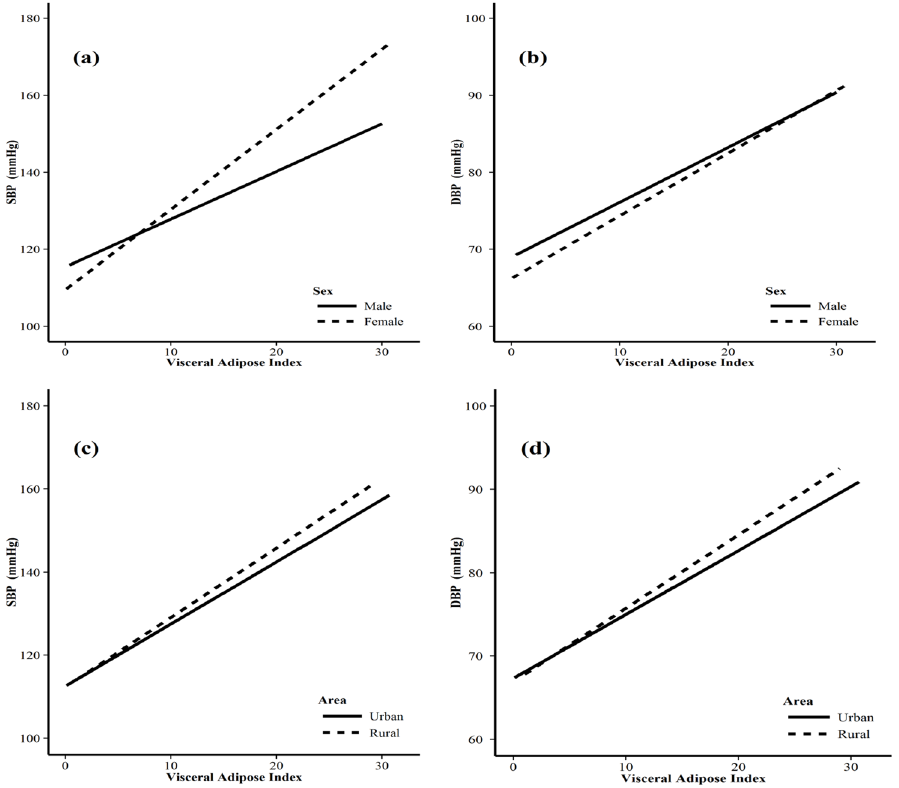
Fig 1. Mean systolic and diastolic blood pressure by VAI between different gender and areas. (a) mean SBP by VAI between different genders; (b) mean DBP by VAI between different genders; (c) mean SBP by VAI between different areas; (b) mean DBP by VAI between different